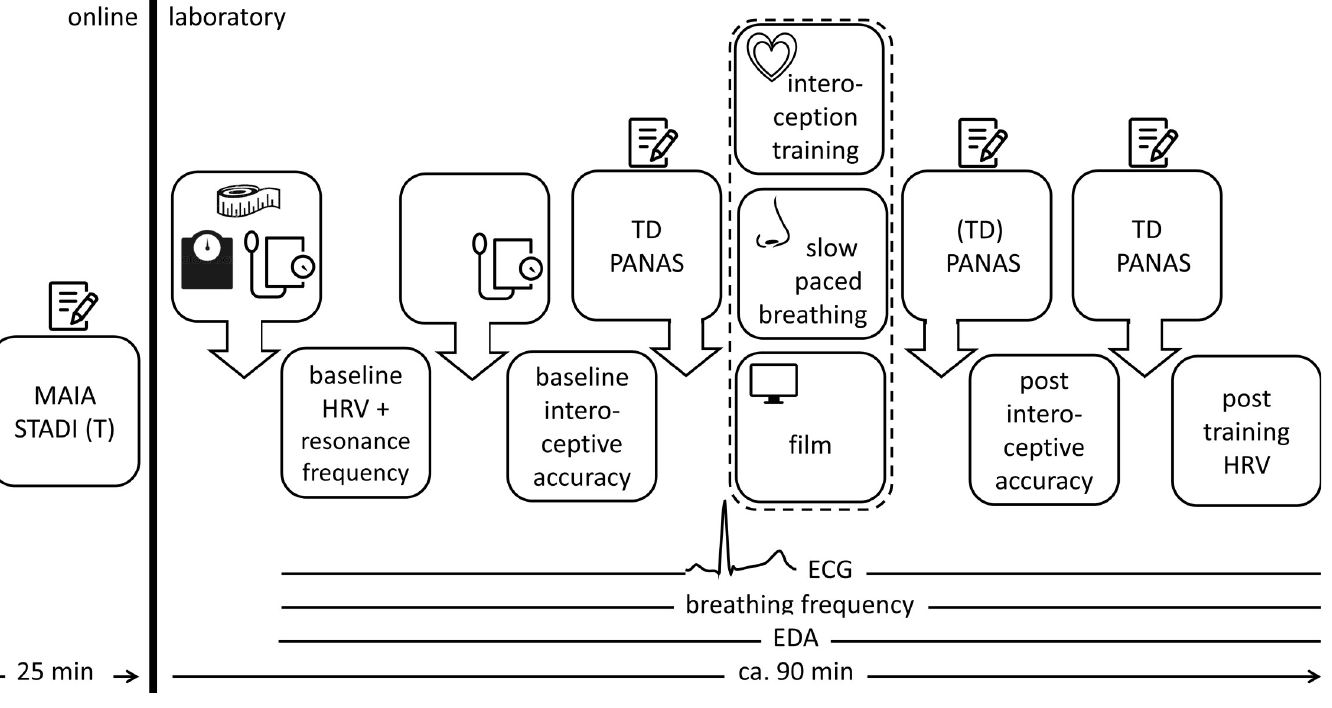
Fig 2. Procedure of the pre-registered replication